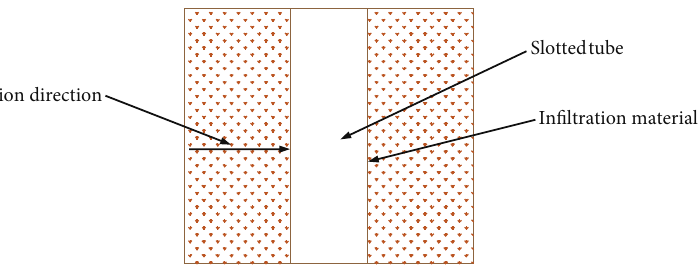
Figure 3: The motion area of tailing sand